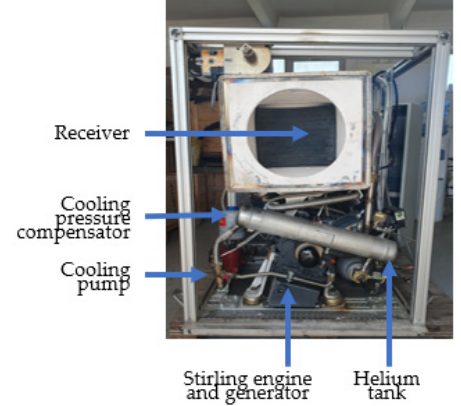
Figure 5. Solar conversion unit.